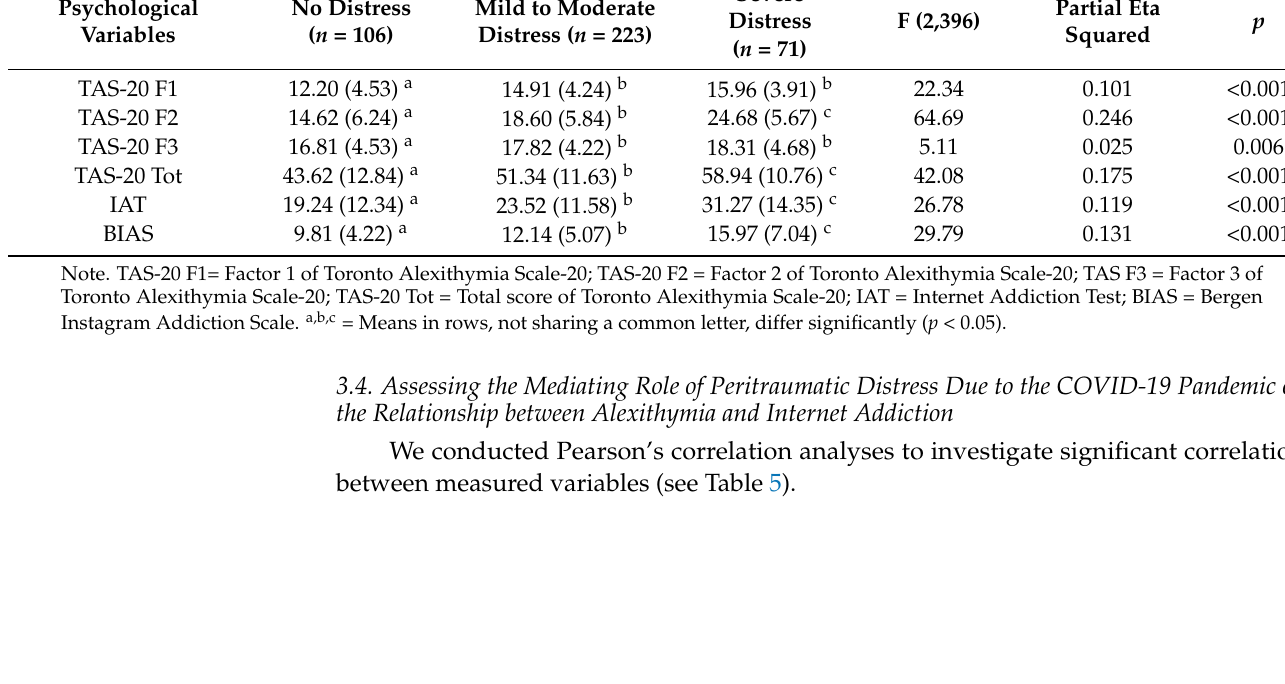
Table 4. Means, standard deviation, F, and partial eta squared of boys’ and girls’ scores on CDPI, TAS-20, IAT, and BIAS. Psychological